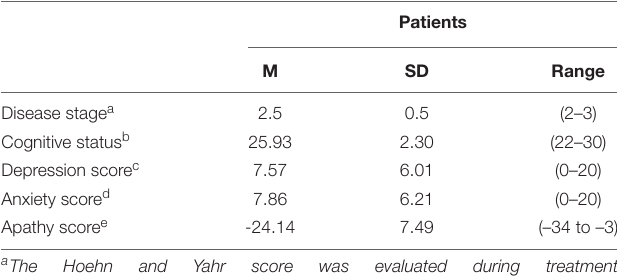
TABLE 2 | Means (M), standard deviations (SD), and ranges of clinical